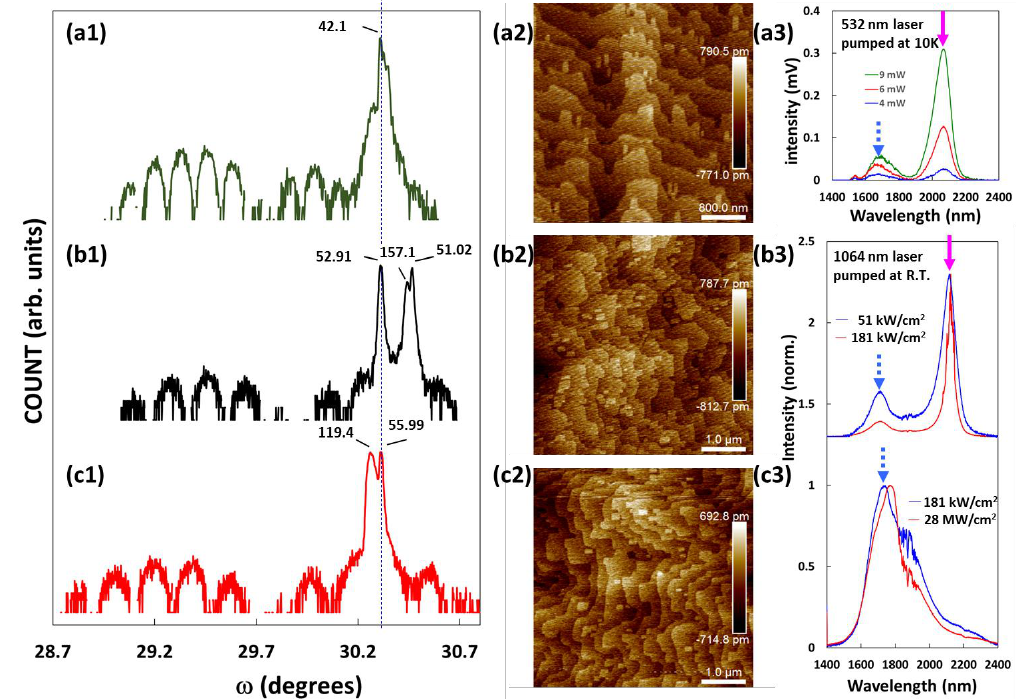
Figure 4. High-resolution X-ray diffraction (HRXRD), atomic force microscopy (AFM), and photoluminescence (PL) results obtained from the ( a 1– a 3) QW device; ( b 1– b 3) sample A; and ( c 1– c 3) sample B. In the rocking curves, the blue dotted line indicates the peak position of the GaSb substrate, whereas the numbers near each peak are the full width at half maximum (unit: aresec). The rocking curves are offset vertically for clarity. The blue dotted arrows and pink arrows in the PL results indicate the emissions of Al 0.3 Ga 0.7 As 0.026 Sb 0.974 and In 0.35 Ga 0.65 As 0.095 Sb 0.905 , respectively. The input power or power density of the laser are also shown in the PL curves.